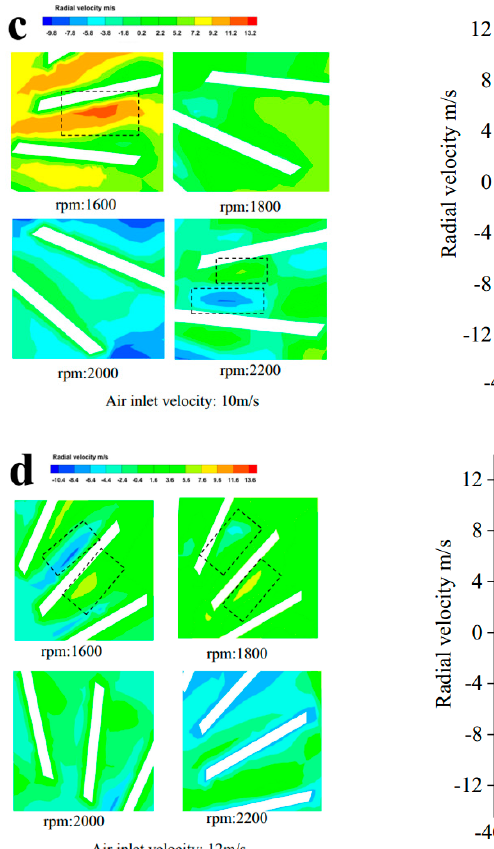
Figure 4. Contours of the air radial velocity distribution between rotor blades and radial velocity contrast under di ff erent radial distances from the axis at di ff erent process parameters ( − 345–305mm, 305–345mm is the area between the rotor blades, − 305–305 mm is the central region).( a ) Air inlet velocity 6 m / s and 4 di ff erent rotor cgae speed. ( b ) Air inlet velocity 8 m / s and 4 di ff erent rotor cgae speed. ( c ) Air inlet velocity 10 m / s and 4 di ff erent rotor cgae speed. ( d ) Air inlet velocity 12 m / s and 4 di ff erent rotor cgae speed